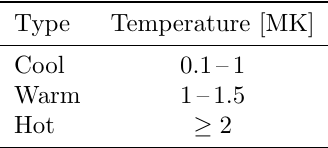
Table 2: Thermal coronal loop